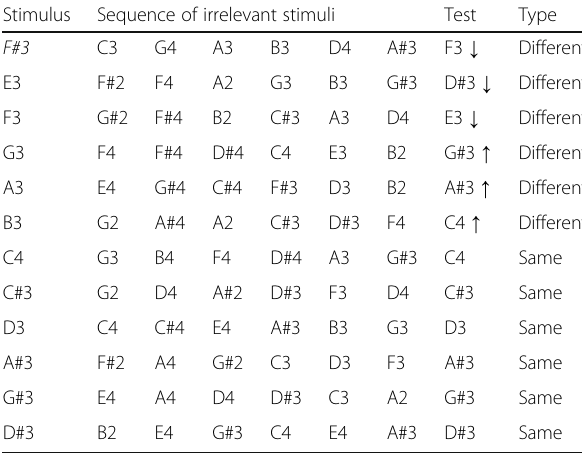
Table 4 The twelve tones used as stimuli and the respective test stimuli, with the irrelevant tones that were presented during the retention interval. The test stimulus could be the same as the memorized one, or being a semitone above ( ↑ ) or below ( ↓ ) the memorized one in the “ different ”